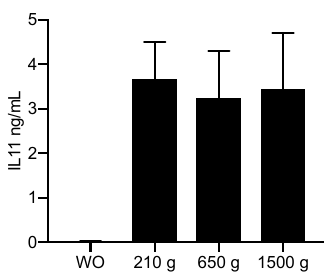
Figure 2. PRF lysates prepared at 210 g , 650 g and 1500 g accumulate IL11 in the cell supernatant. Gingival fibroblasts were exposed to 30% of PRF lysates prepared at 210 g , 650 g and 1500 g . The levels of IL11 in the supernatant of the fibroblasts are presented in ng / mL. Bar graphs show the means and standard deviation of four independent experiments. Statistical analysis was based on an ANOVA.